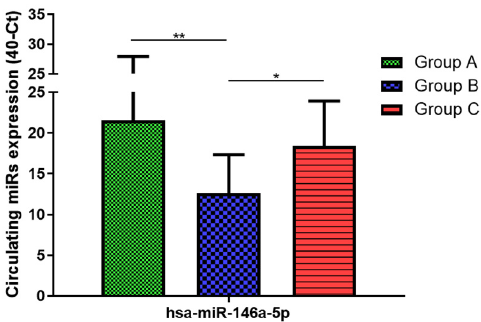
Figure 5. Serum levels of hsa-miR-146a-5p in HNW (Group A), MANW (Group B) and HNAO (Group C). Results were shown as means ± SD. The statistical tests used in these analyses were one-way analysis of variance using Kruskal–Wallis test followed by Dunn’s Multiple Comparison Test. * p < 0.05, ** p < 0.01.